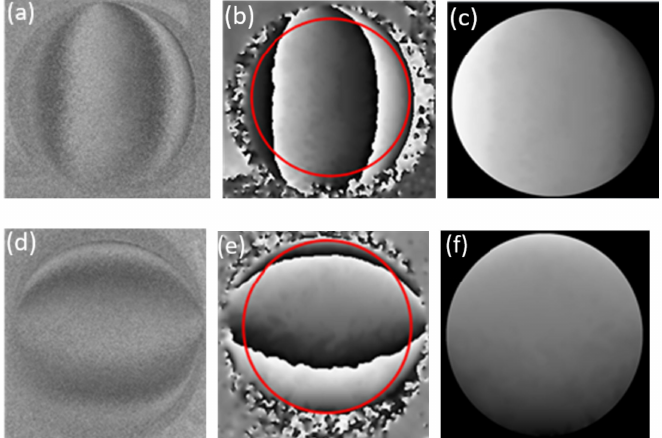
Figure 6. The phase maps corresponding to the ball under test, including ( a ) the raw phase map, ( b ) the filtered phase map, ( c ) the unwrapped phase map in the X direction, ( d ) the raw phase map, ( e ) the filtered phase map, and ( f ) the unwrapped phase map in the Y direction. The overlapped area in the phase maps is identified with red